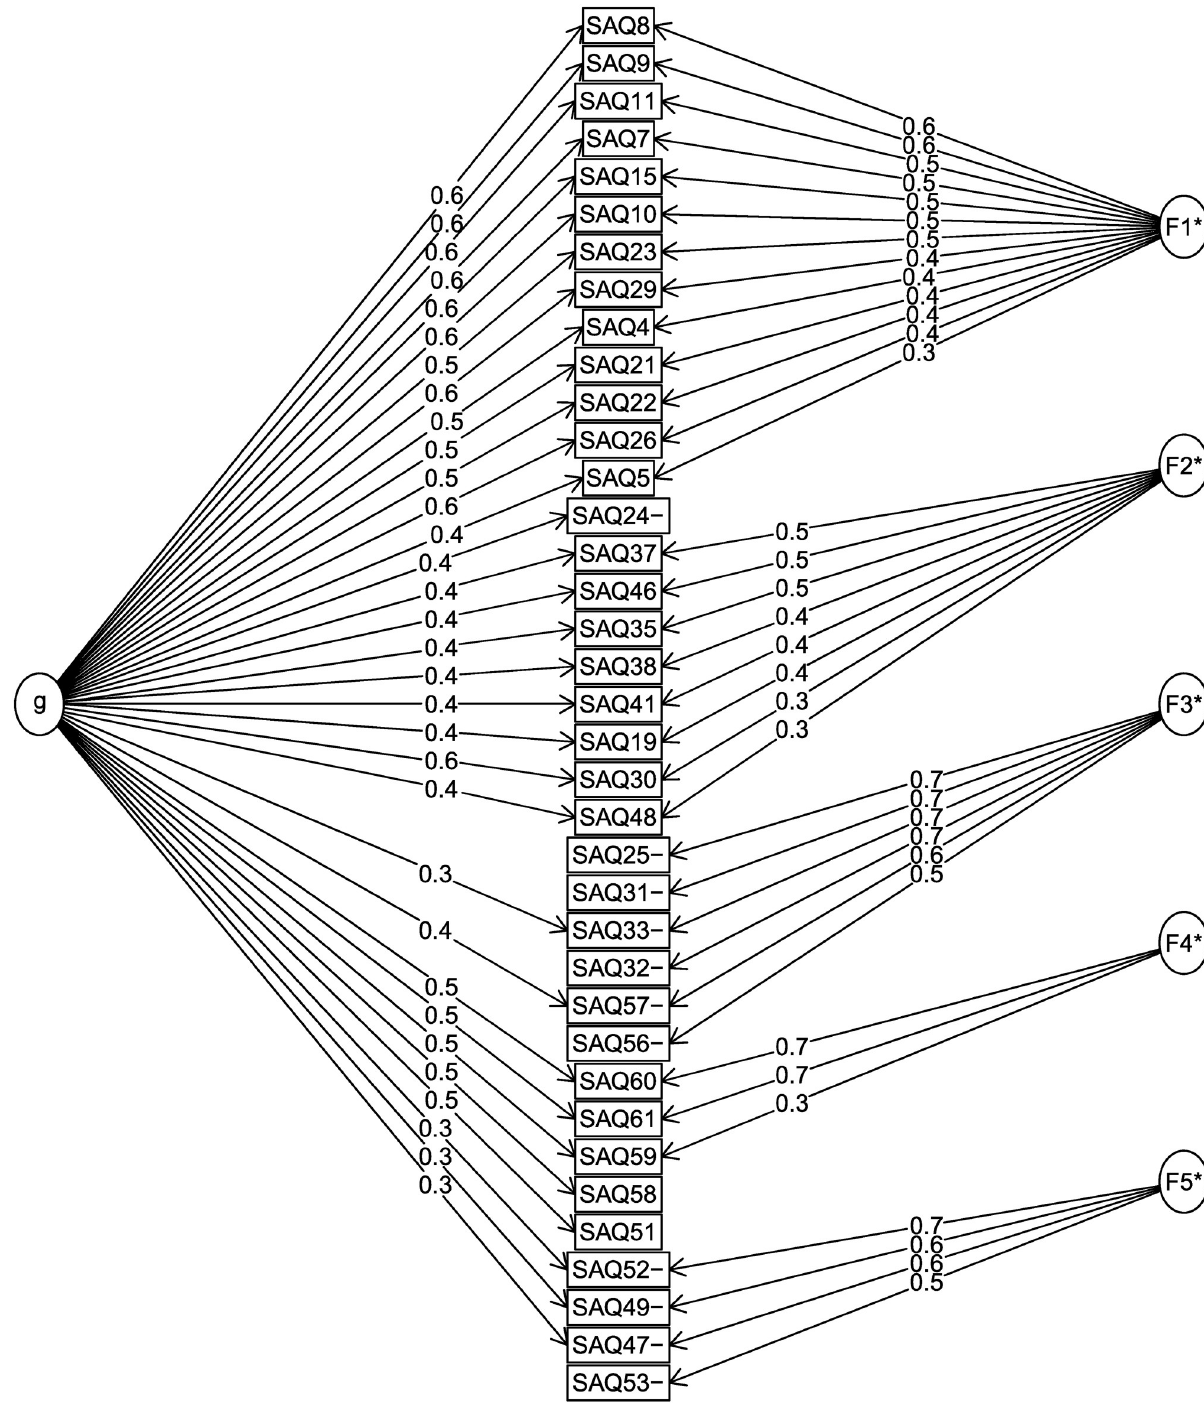
Fig 1. Factor structure